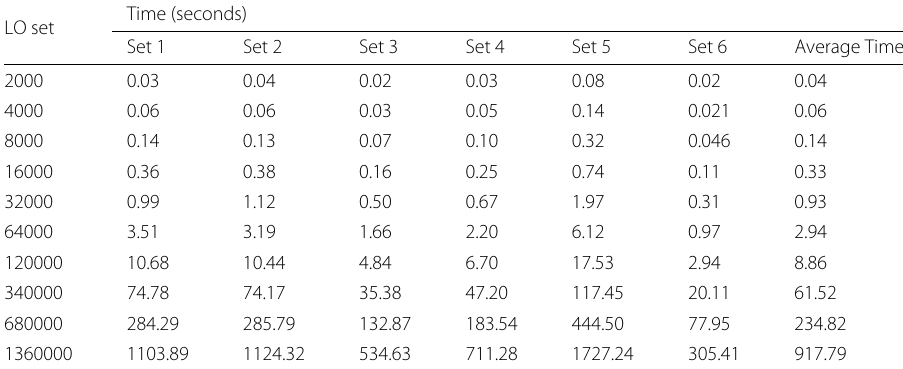
Table 4 Response time of the classic algorithm for each set of LO LO